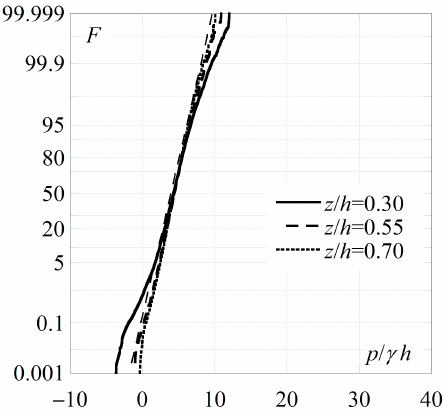
Figure 10. Probability distribution function F of fluctuating pressures yet uninfluenced by the slope reduction, for d c / h = 4.6 and the 50° module (at step − 2), at ( a ) z / h = 0.30, ( b ) z / h = 0.55, and ( c ) z / h = 0.70. (---) Normal distribution.